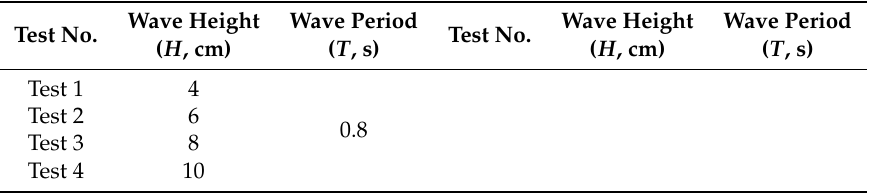
Table 4. Wave conditions of the